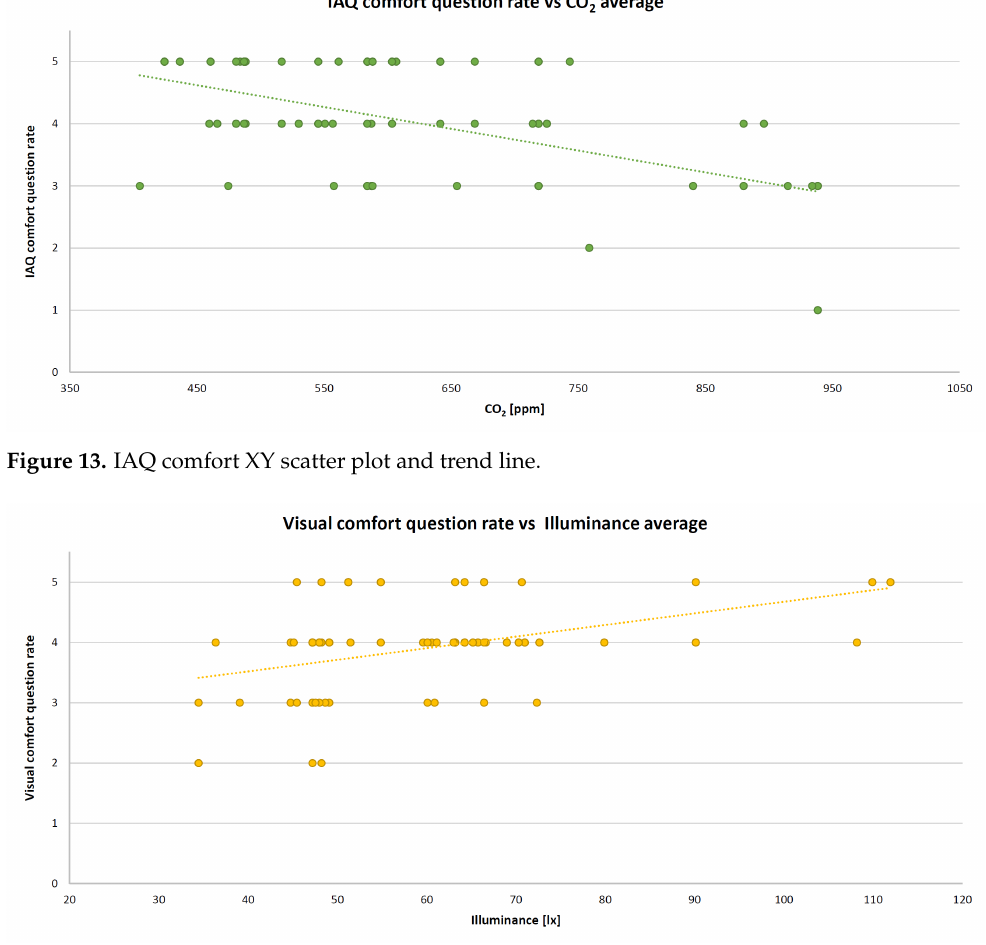
Figure 14. Visual comfort XY scatter plot and trend line.